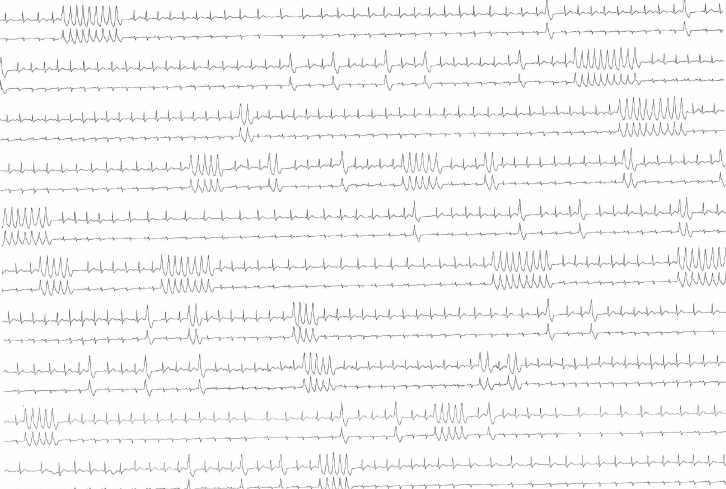
Figure 2: ECG telemetry with sinus tachycardia, ventricular extrasystoles, and multiple episodes of non-sustained monomorphic ventricular